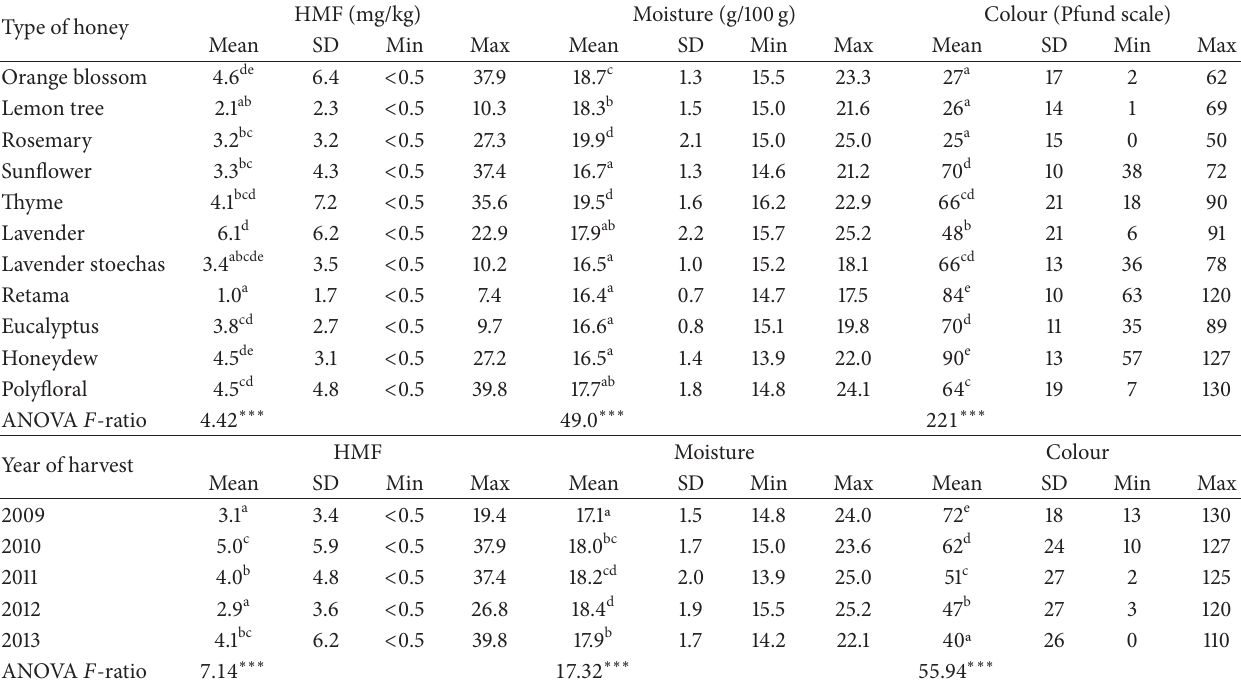
Table 1: Descriptive statistics for moisture, colour, and HMF for each variety of honey and year of harvesting. ANOVA results ( 𝐹 -ratio and significant differences) obtained for two factors: type of honey and year of